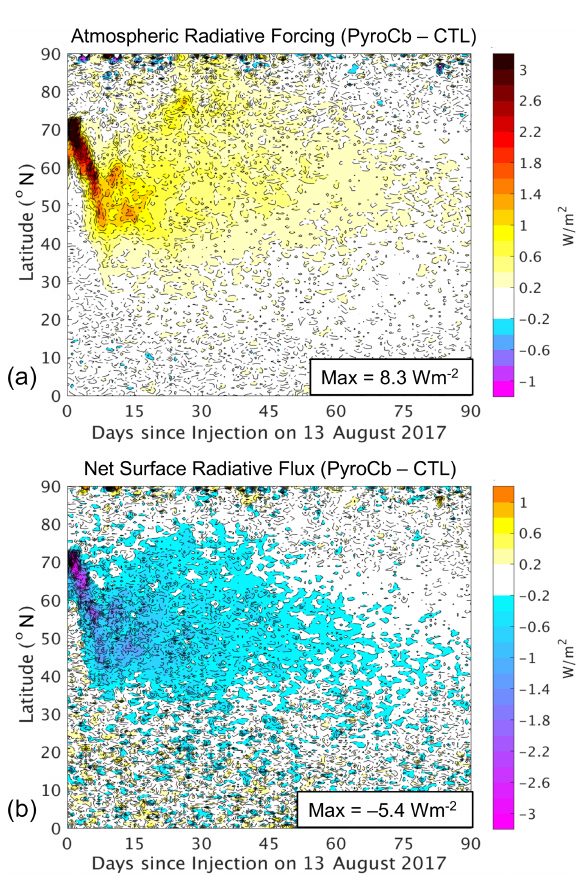
Figure 11. Impacts of pyroCb-emitted aerosols on radiation bal- ance. Differences in zonal mean all-sky (a) atmospheric radiative forcing and (b) net surface radiative flux between the pyroCb and control (CTL) experiments. The maximum values are listed at the bottom corner of each panel since color scales are saturated for high AOD values during the initial days after the injection.